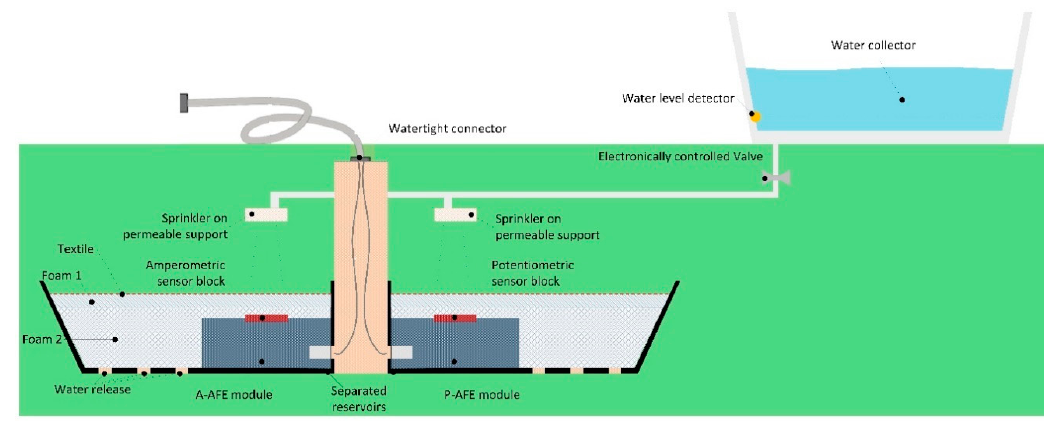
Figure 3. Soil Probe Figure 3 . Soil Probe Architecture .